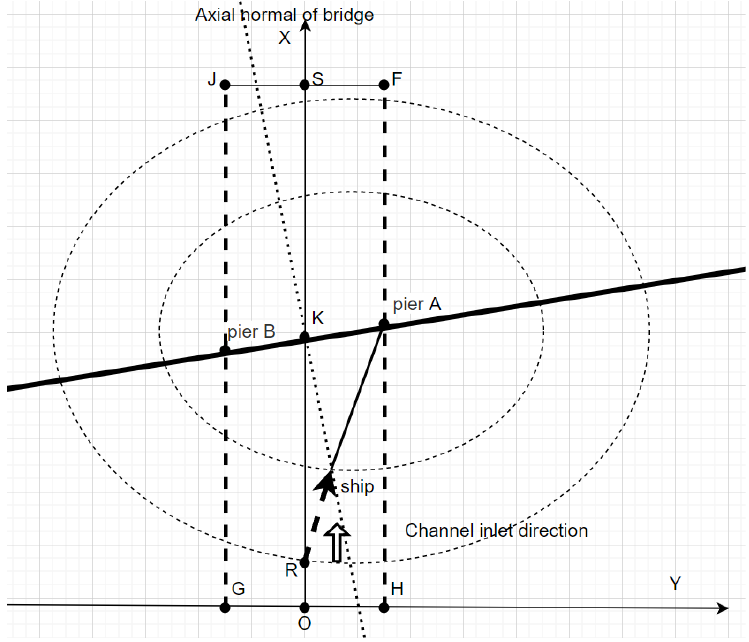
Figure 2. Bridge–ship coordinate system.